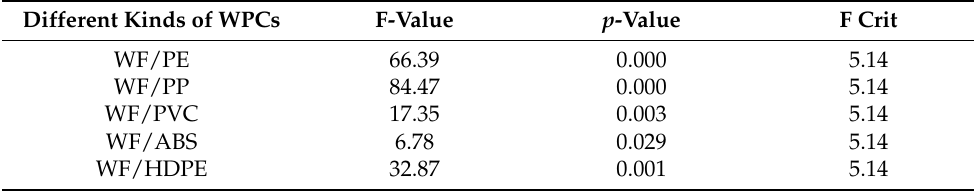
Table 2. ANOVA of flexural strength of